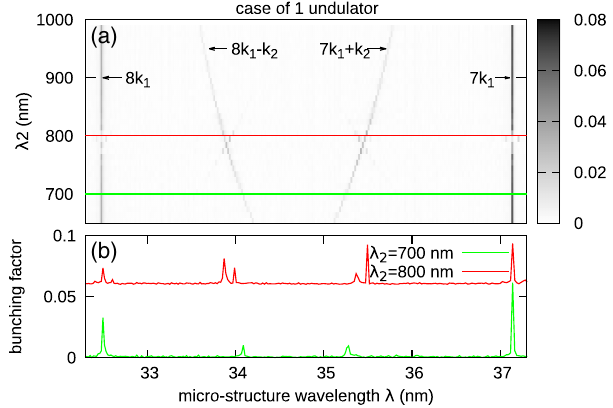
FIG. 4. (a) Bunching factor bf ð λ Þ versus λ 2 in the case of 1 undulator. (b) Detail for (red) λ 2 ¼ 800 nm and (green) λ 2 ¼ 700 nm (for figure clarity, the red line is vertically shifted by 0.06). Other parameters are the same as in Fig. 3 except λ